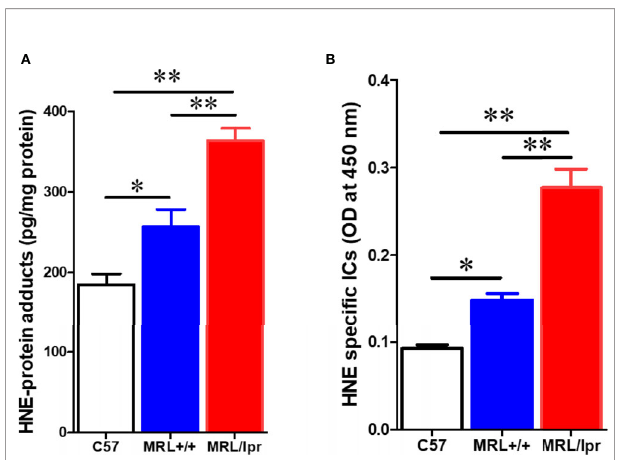
FIGURE 7 | Elevated markers of oxidative stress in the colon of lupus-prone mice. Colon protein samples were subjected to speci fi c ELISA for HNE- protein adducts and HNE-speci fi c ICs. (A) HNE-protein adducts. (B) HNE- speci fi c ICs. Results are mean ± SEM. n = 4 * p < 0.05; ** p <